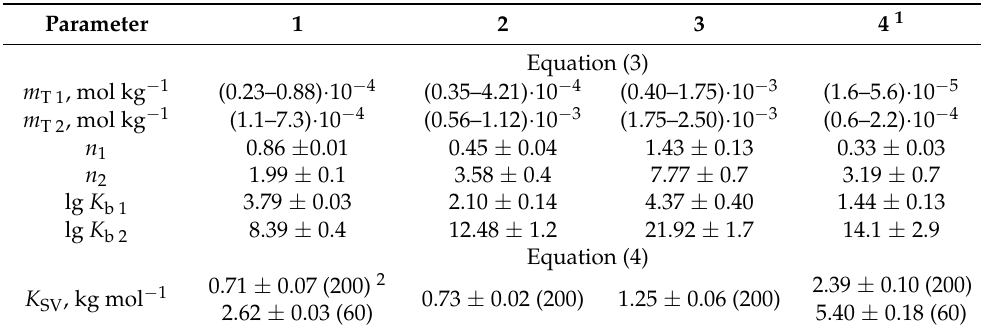
Table 2. Parameters of Equation (3) and the Stern–Volmer constants for comps. 1 – 4 .